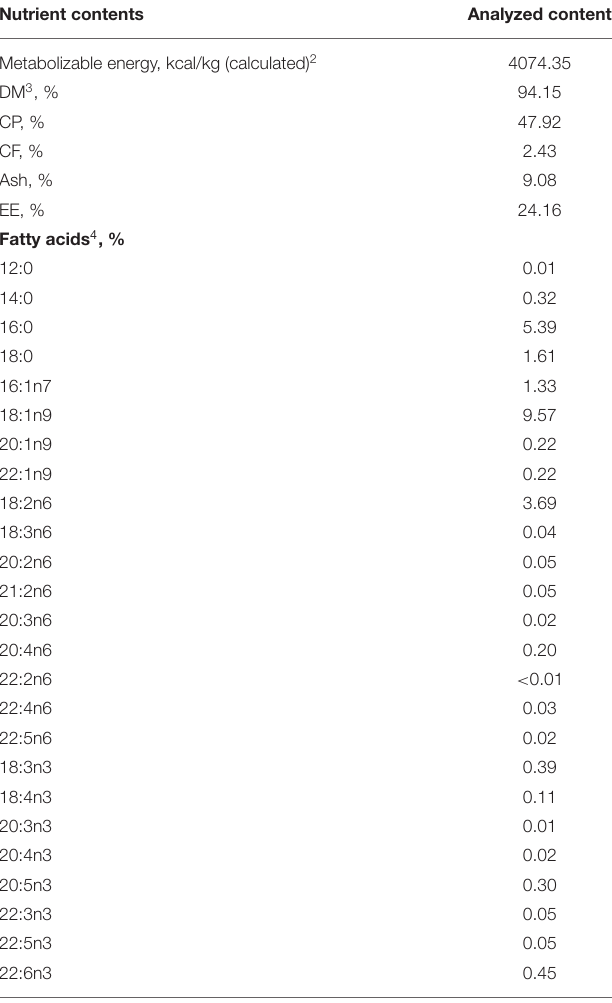
TABLE 1 | Diet nutrient content on dry matter basis and ingredient composition 1